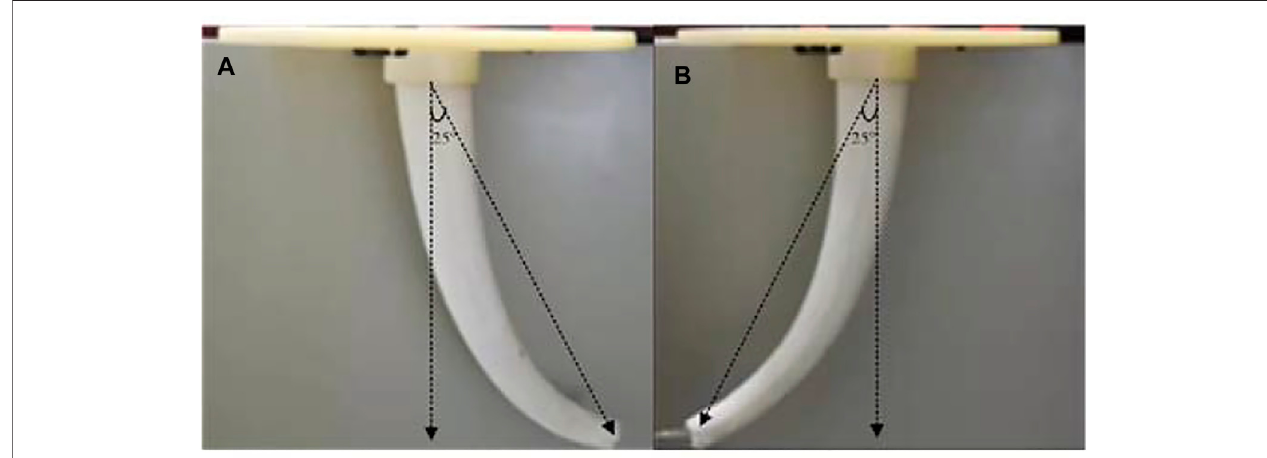
FIGURE 13 | Frame-by-frame analysis of the video of the straight walking on the fl at ground.